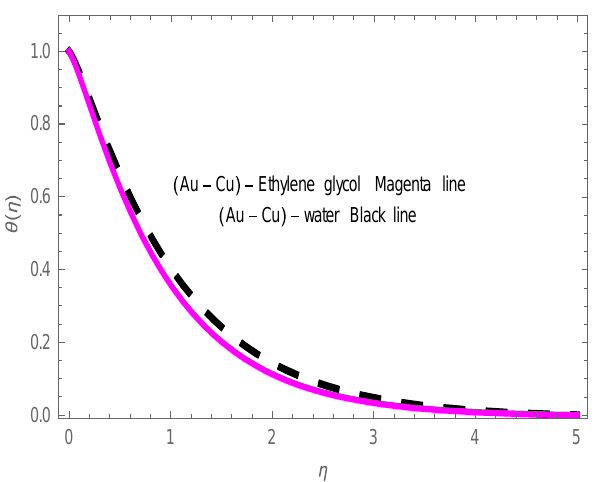
Figure 7. 𝜃(𝜂) for (Au-Cu)/Water and (Au-Cu)/Ethylene hybrid nanofluids. Figure 7. θ ( η ) for (Au-Cu)/Water and (Au-Cu)/Ethylene hybrid